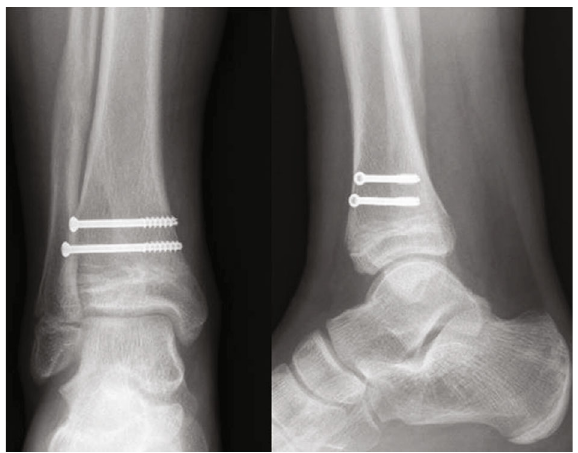
Figure 6: Anteroposterior and lateral radiographs of the ankle at 18-month